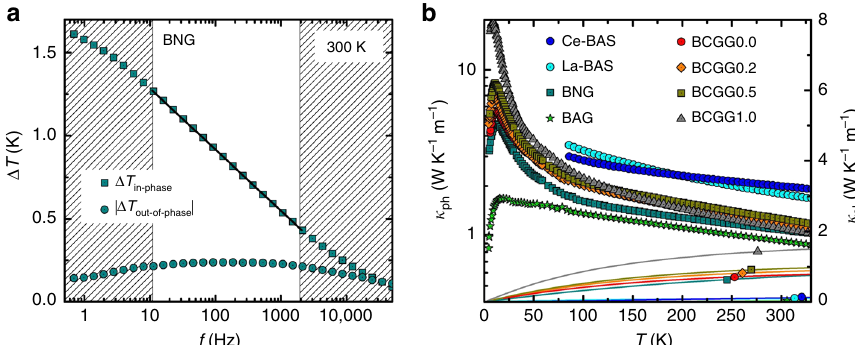
Fig. 2 Thermal conductivity data of type-I clathrate single crystals. a Exemplary frequency scan in the 3 ω setup. Rectangles show the in-phase, circles the out-of-phase contribution of the temperature oscillation Δ T . The expected linear-in-logarithmic-frequency dependence of the in-phase temperature oscillation of the heater/thermometer line, that is observed at intermediate frequencies (between the hatched areas), is measured with an extremely low noise level. The slope of this dependence (full line) is inversely proportional to the thermal conductivity κ of the studied material. b Temperature-dependent thermal conductivity of all studied materials. The data points represent the phonon thermal conductivities κ ph , calculated by subtracting an electronic contribution κ el (lines and identi fi er symbols, right axis) from the total measured κ . Each data point above 80 K is determined from the slope of an isothermal Δ T vs log f curve (straight line in a ). All sample compositions are given in the Supplementary Table 1